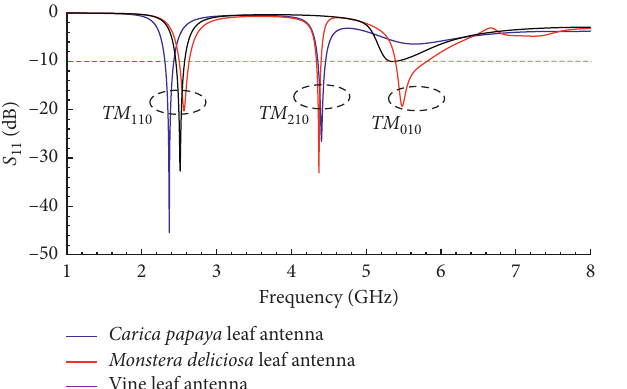
Figure 10: Gain and efficiency of the vine-leaf BioAs-MPA antenna.